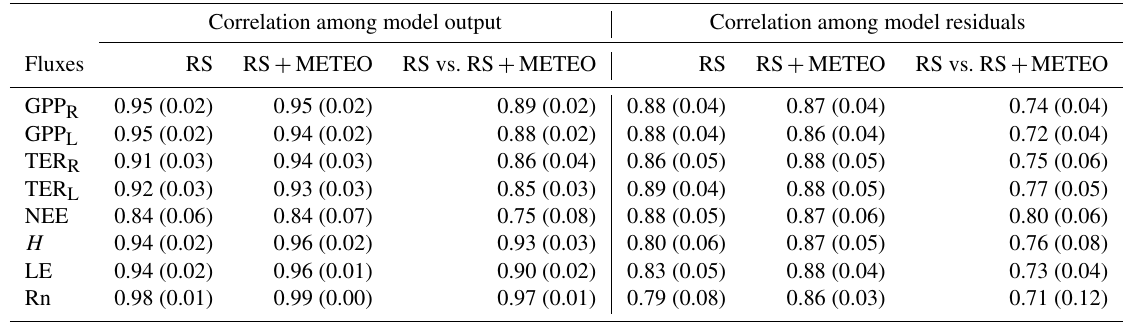
Table B1. Mean values of the determination coefficient ( R 2 ) by the pairwise comparison of the models’ output and their residuals. We com- pared different MLs and the same drivers (RS and RS + METEO, respectively) or the same ML and different drivers (RS vs. RS + METEO). Numbers in parentheses were the standard deviation of R 2 . All correlations were statistically significant ( p